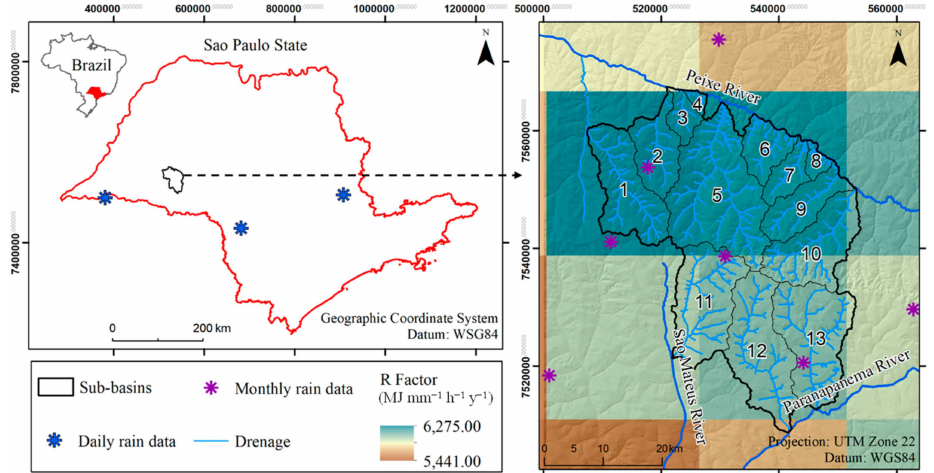
Figure 3. The sub-basins’ geographic location with the distribution of daily rain data gauges in Sao Paulo State, Brazil and the monthly rain data gauges on the rainfall erosivity (R-Factor)